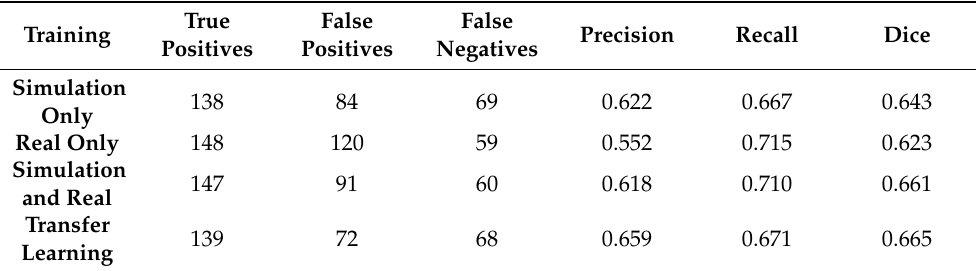
Table 1. Detection performance for networks trained using simulations, real data, a combination of both, and transfer learning. Decision thresholds were used as found from the training data for each